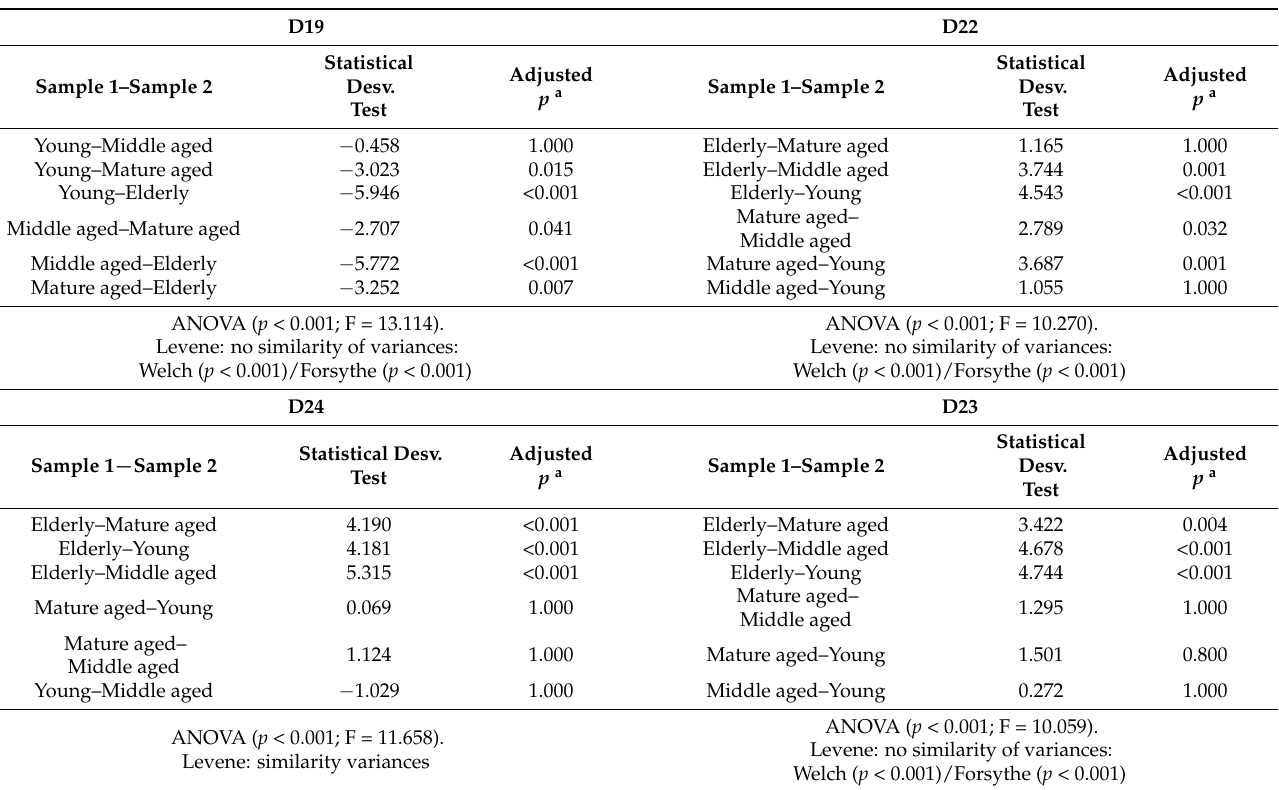
Table 3. Pair comparisons. Age of